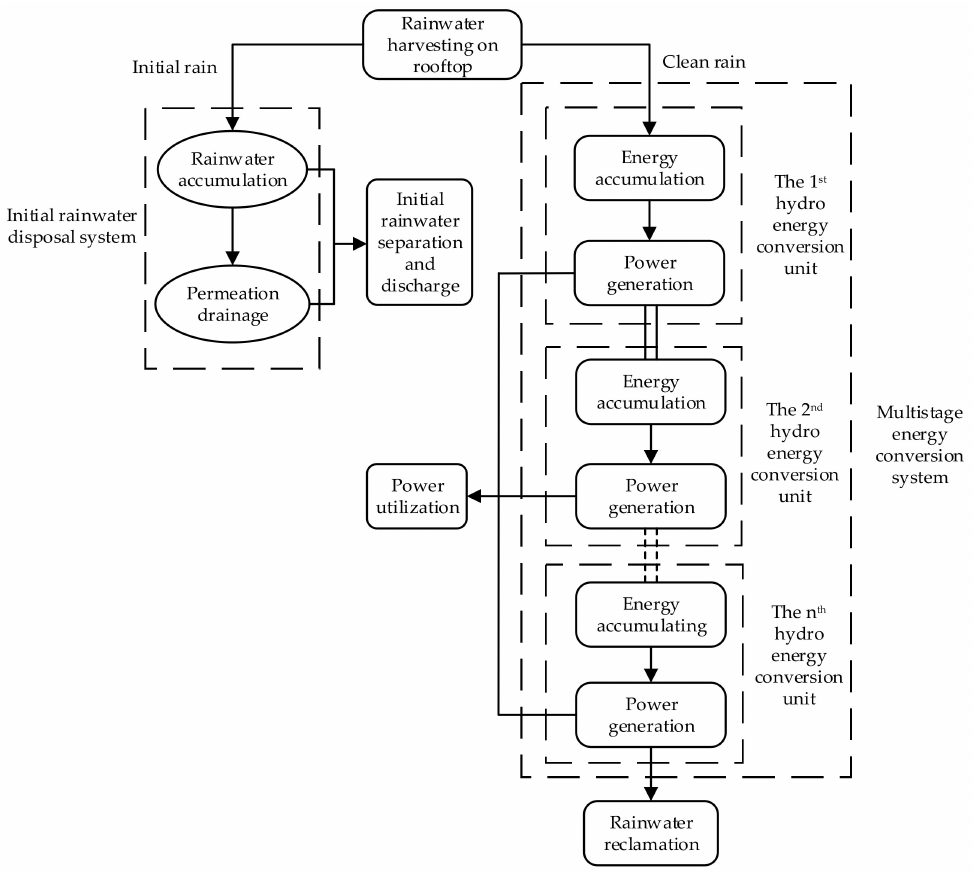
Figure 1. Overall framework of the Rain-Power Utilization System, including two subsystems and six